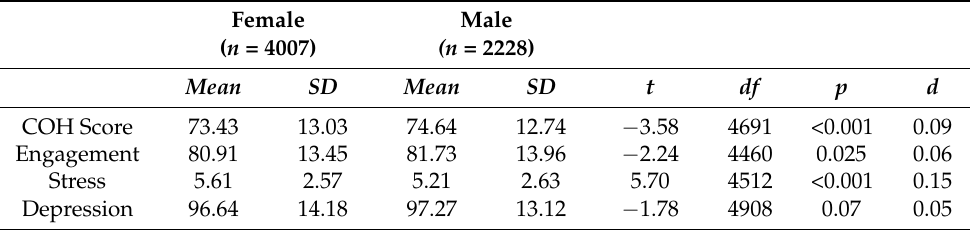
Table 1. Descriptive statistics and results of t -test comparison of employee outcome variable by gender.